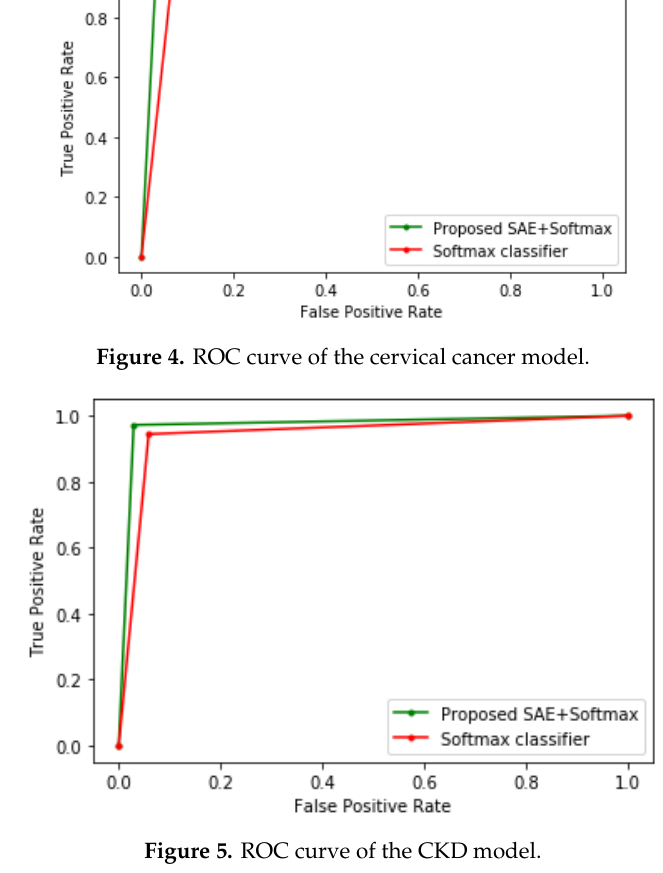
Figure 5. ROC curve of the CKD model.